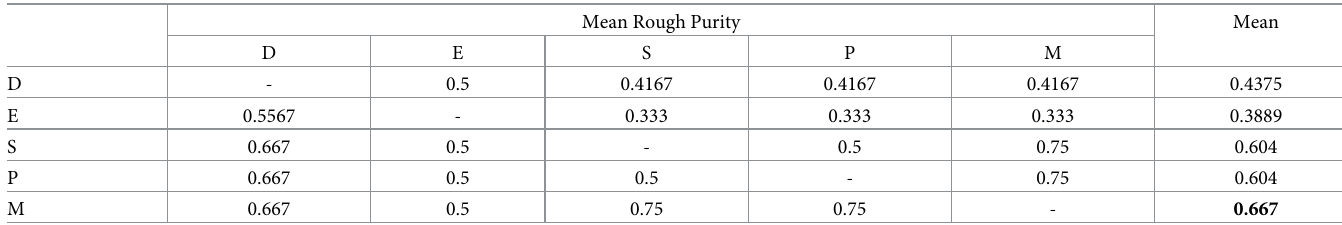
Table 9. MMP roughnes of Table